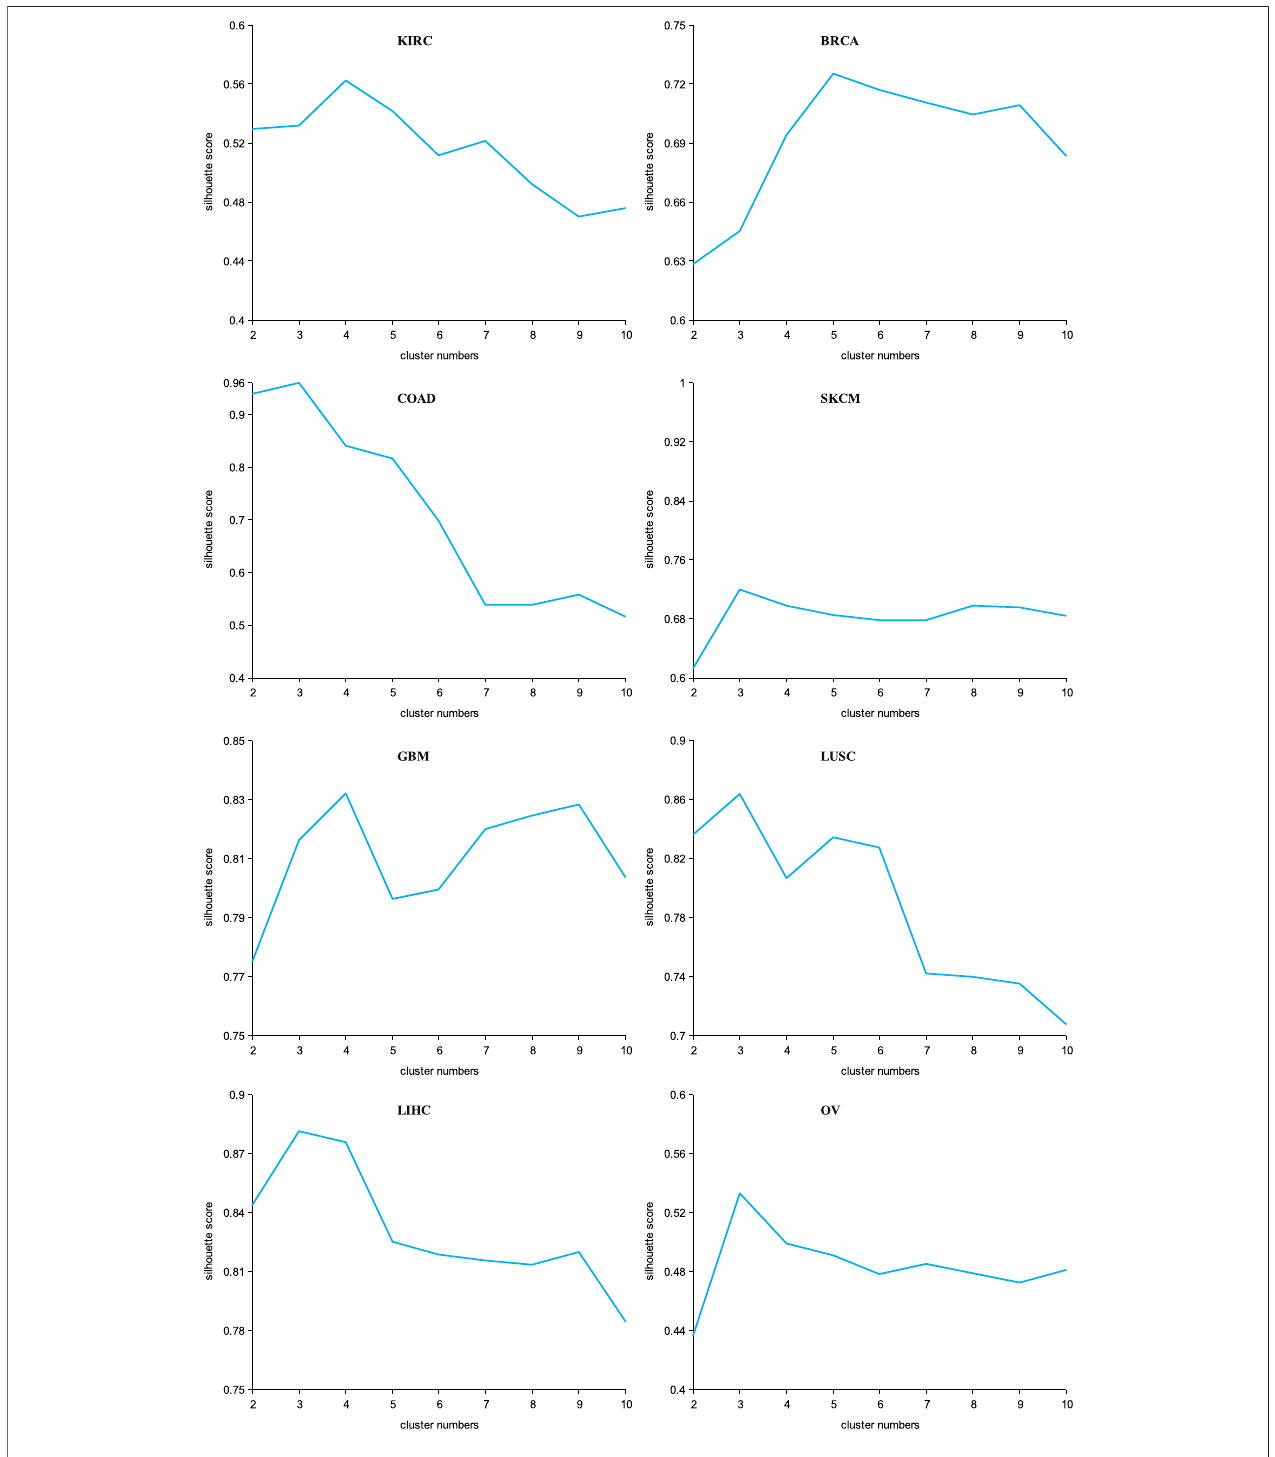
FIGURE 2 | Silhouette width multiGATAE achieved on the eight